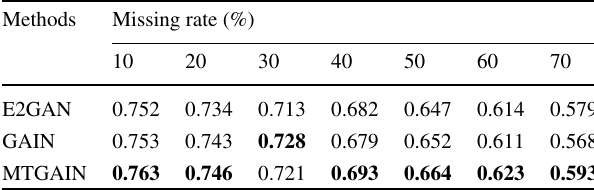
Table 1 The AUROC results in various missing